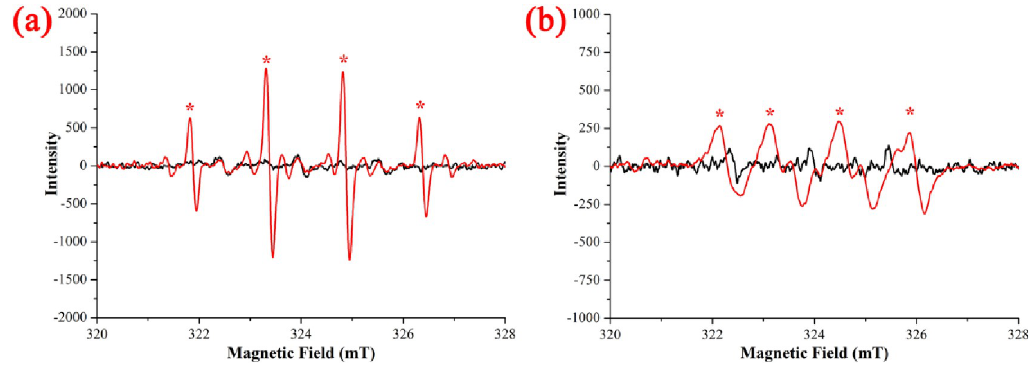
Fig 9. ESR measurements of � OH (a) and � O 2- (b).